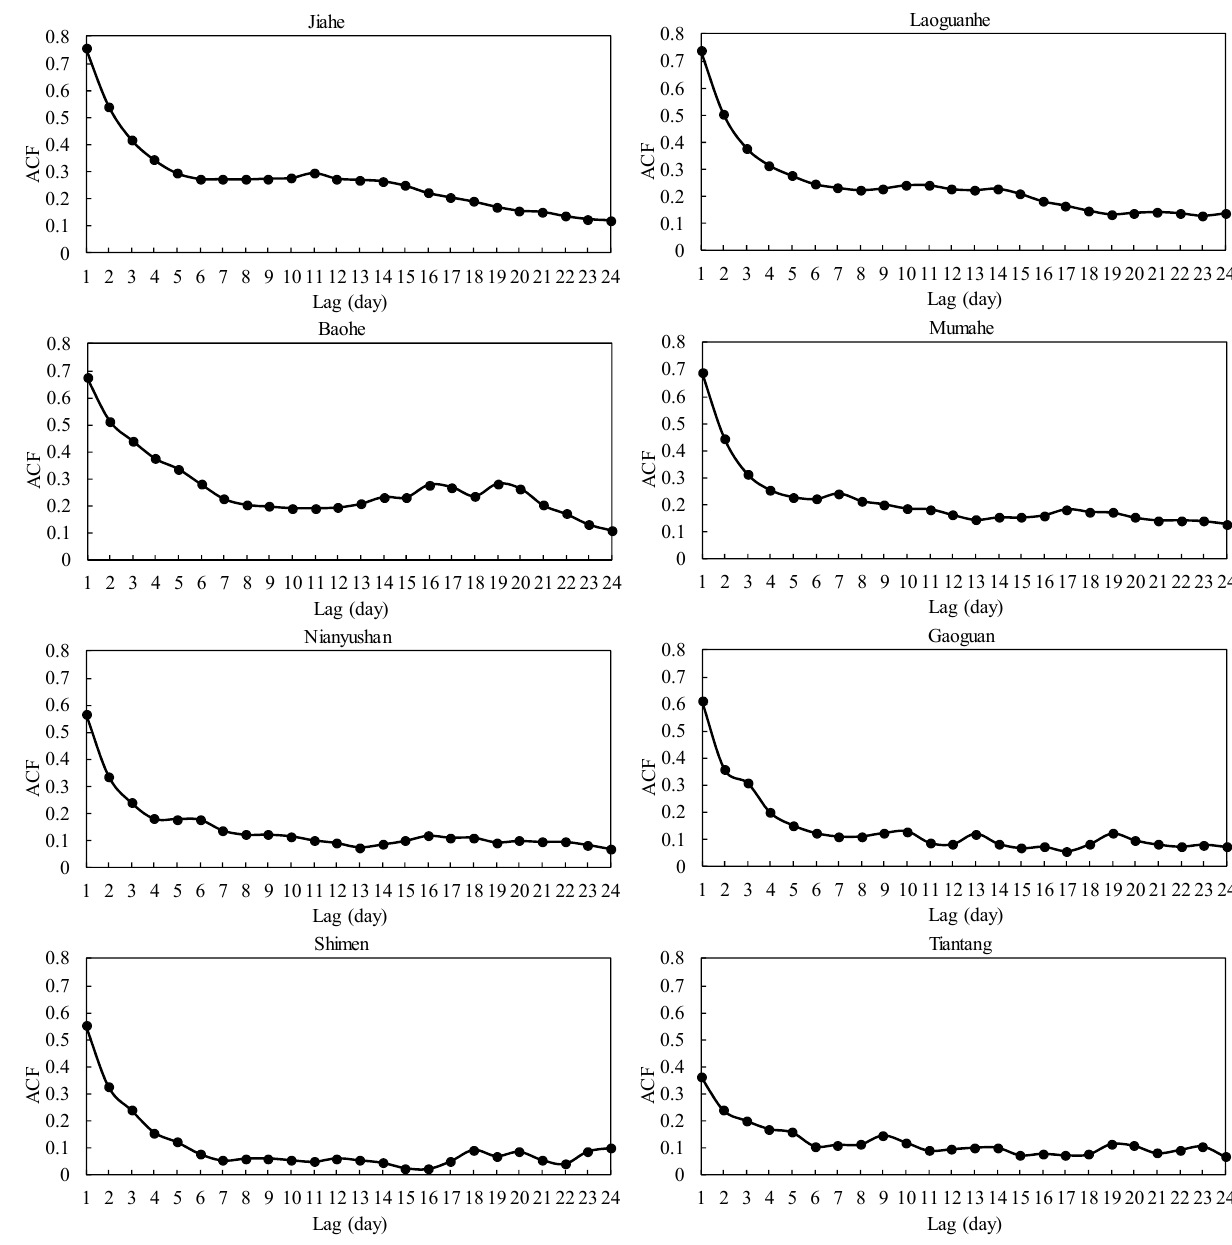
Figure 3. Autocorrelation function (ACF) values of runoff series for all